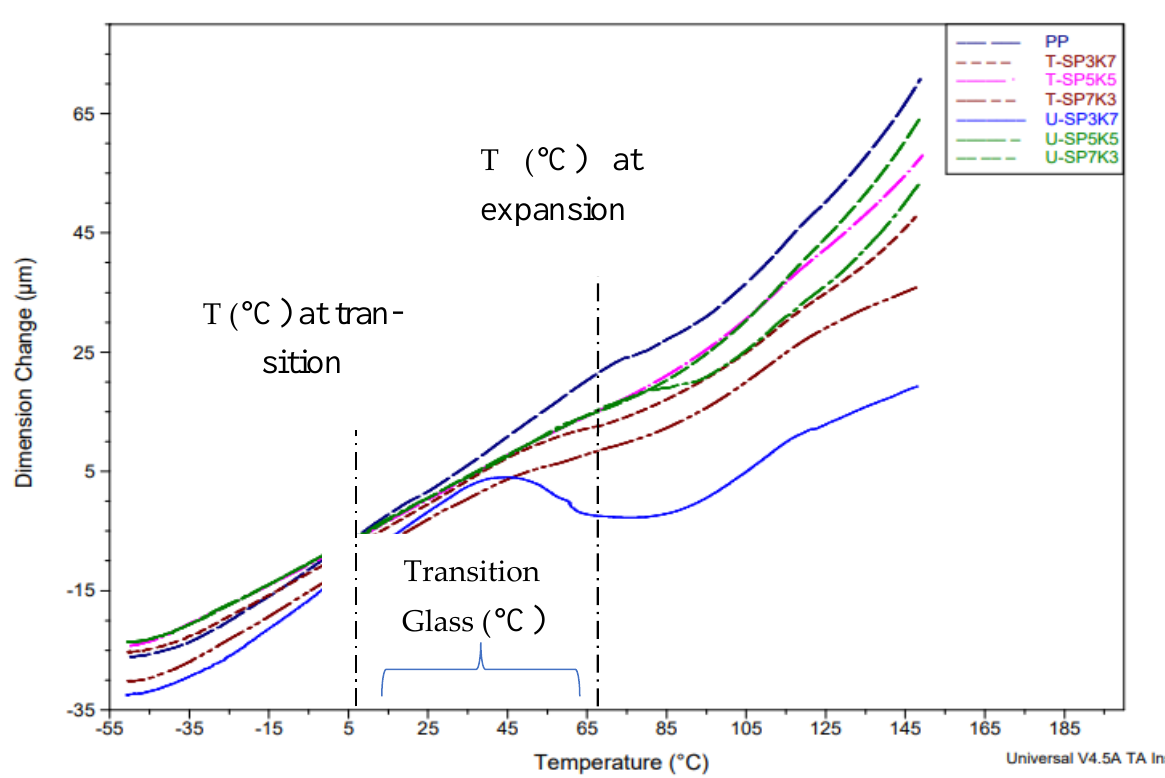
Figure 8. Thermogram of the dimension change in varied compositions of SP/K/SP hybrid Figure 7. Thermogram of the dimension change in varied compositions of SP/K/SP hybrid composites. Table 6. Thermal expansion after 45 °C and 105 °C.